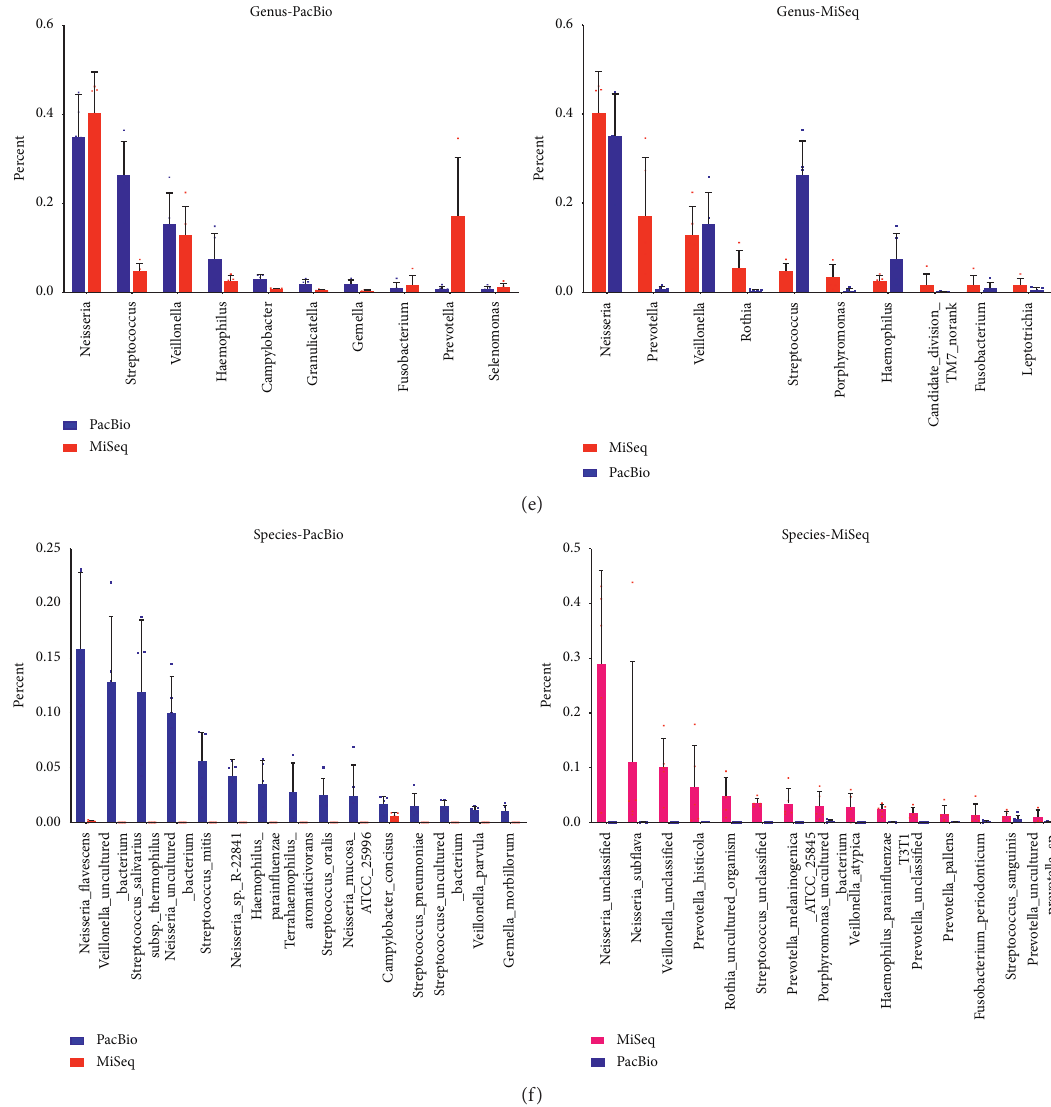
Figure 5: The relative abundance of top 10 phyla, classes, orders, families, and genera and top 15 species. (a) Top 10 phyla. (b) Top 10 classes. (c) Top 10 orders. (d) Top 10 families. (e) Top 10 genera. (f) Top 15